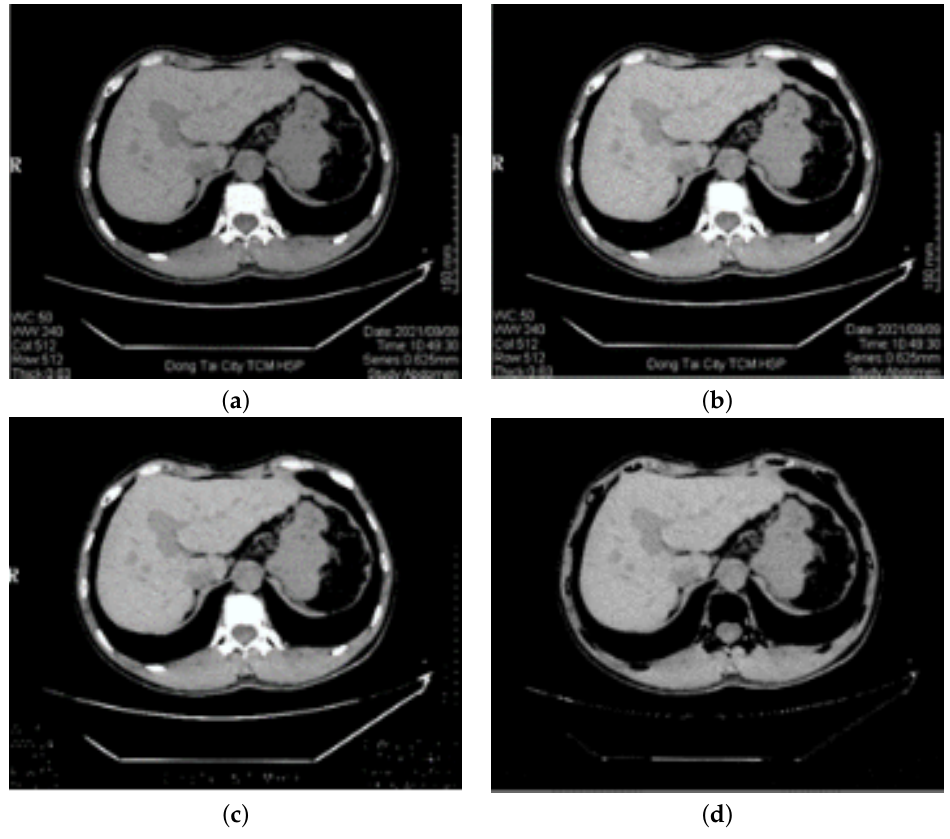
Figure 2. Preprocessing: ( a ) The original image. ( b ) The image after contrast enhancement. ( c ) The image after median filtering. ( d ) The image after bone and text